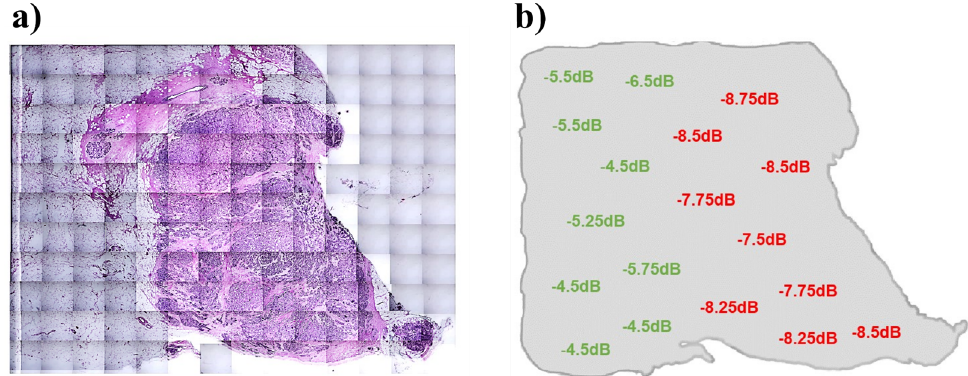
Figure 4. GHz spectroscopy on human tumor margins. ( a ) H&E assay of a measured margin sample, 2.7 × 2.7 cm. ( b ) S 11 magnitude measurements on the selected margin in 18 points. Pathologically negative and positive points are represented in green and red, respectively. The obtained pattern is completely matched with the H&E assay.